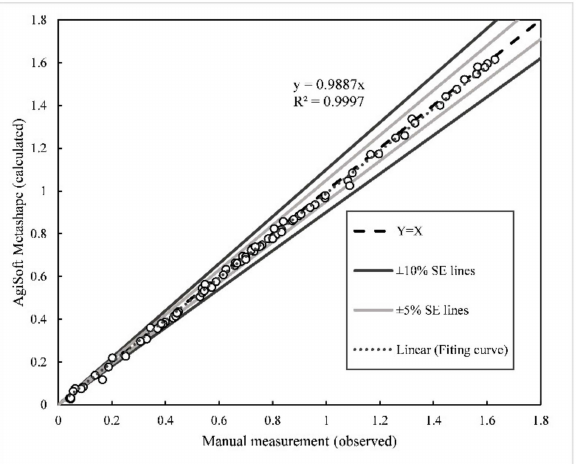
Figure 8. Observed vs. calculated values of the elevation dense point cloud dimensionless index (note: SE lines are the standard error lines representing the average distance the observed values fall from the regression line, linear (fitting curve) is the regression line indicating the agreement rate between the observed and calculated values, and R 2 is the coefficient of determination of the prediction